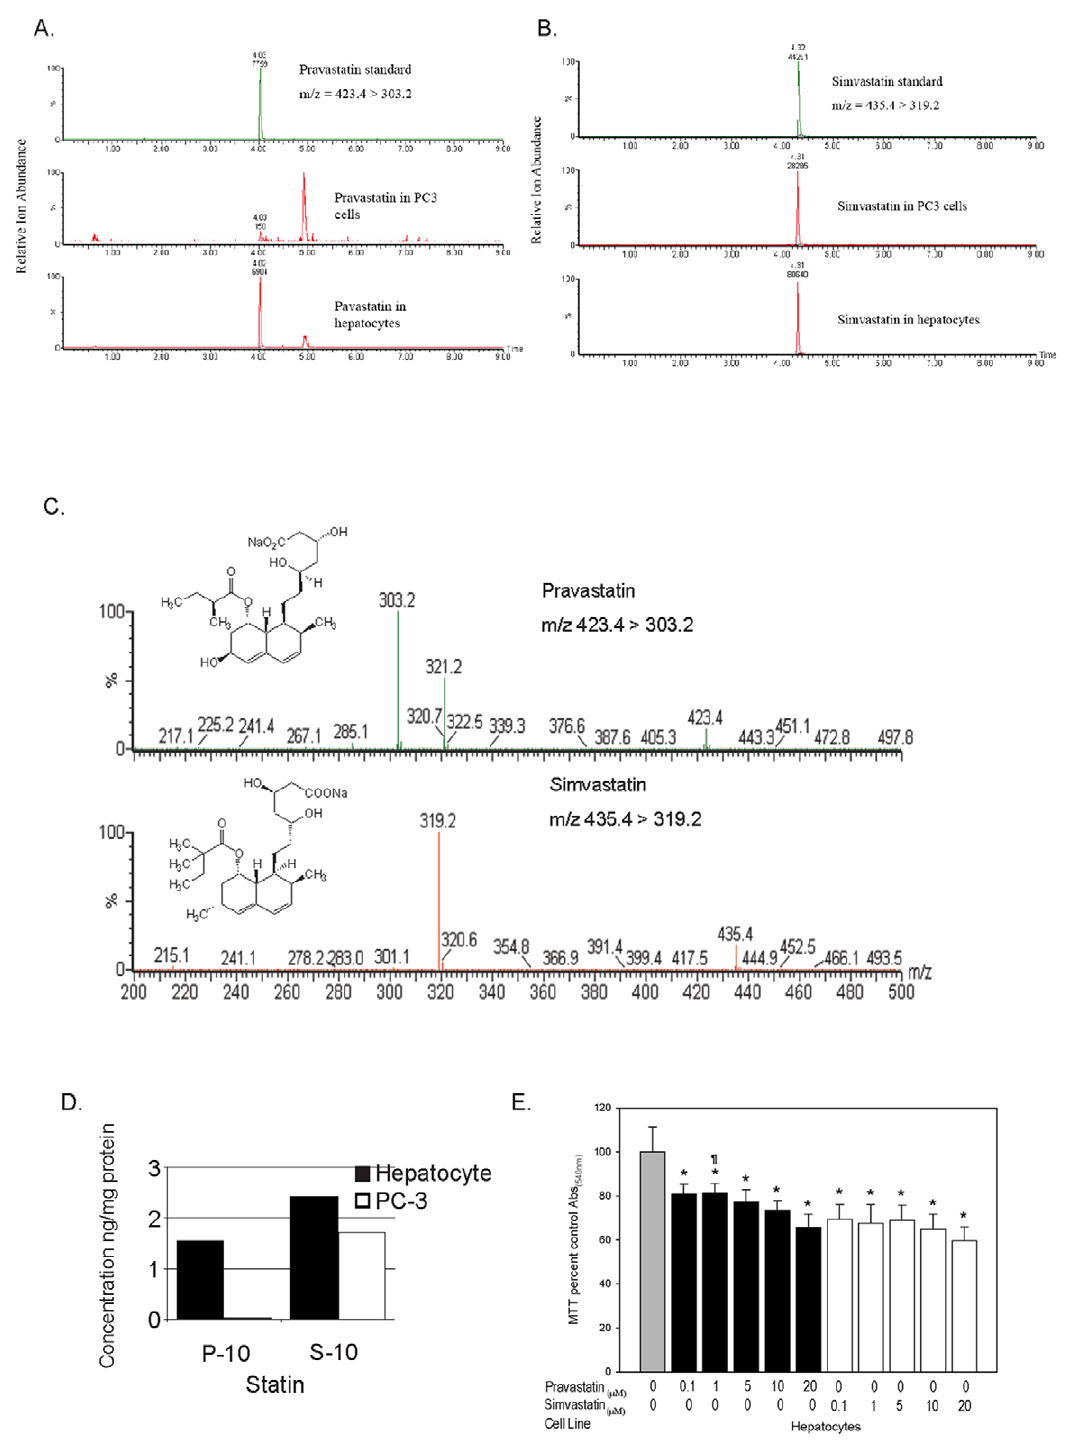
Figure 5. Incorporation and growth response of normal hepatocytes or tumor cells to hydrophilic-pravastatin or hydrophobic- simvastatin. A & B) Total ion chromatography methods were developed to attain critical separation profiles showing pravastatin and simvastatin. C) Mass spectroscopy was performed by using deuterated standards as internal controls for separation to distinguish between statins. Statins were detected by using electrospray-negative ionization and monitoring by magnetic resonance microscopy. Fragmentation of the statins were performed using argon as the collision gas at a collision cell pressure of 2.1 6 10 2 3 torr. D) LS/MS/MS determination of statins. Monolayers of normal hepatocytes or prostate cancer cells (PC-3) were placed in fresh serum-free medium before the addition of 10 m M pravastatin or simvastatin. Cell culture medium and cells were collected 6 h after treatment. The statins were subjected to solid-phase extraction and analyzed for the presence of pravastatin or simvastatin by LC/MS/MS analysis. Data represent two determinations run in duplicate. E) Effects of pravastain and simvastatin on OATP expressing human hepatocytes were determined by MTT assay and are represented as a percent of the control absorbance at a wavelength of 540 nm. Data shown are from representative experiments (n=8). These data illustrate that both pravastatin and simvastatin suppressed the growth of hepatocytes